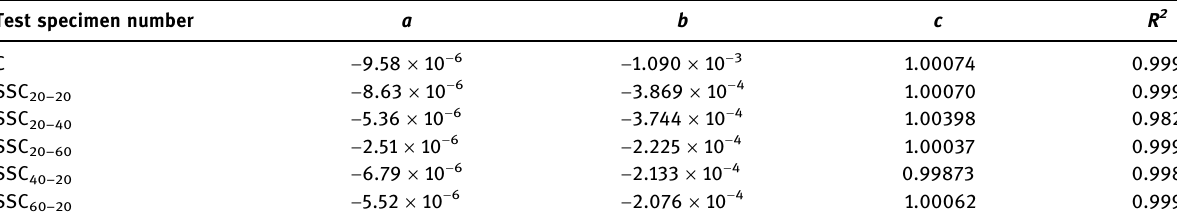
Table 9: Results of the fi tted parameters of the quadratic function Test specimen number